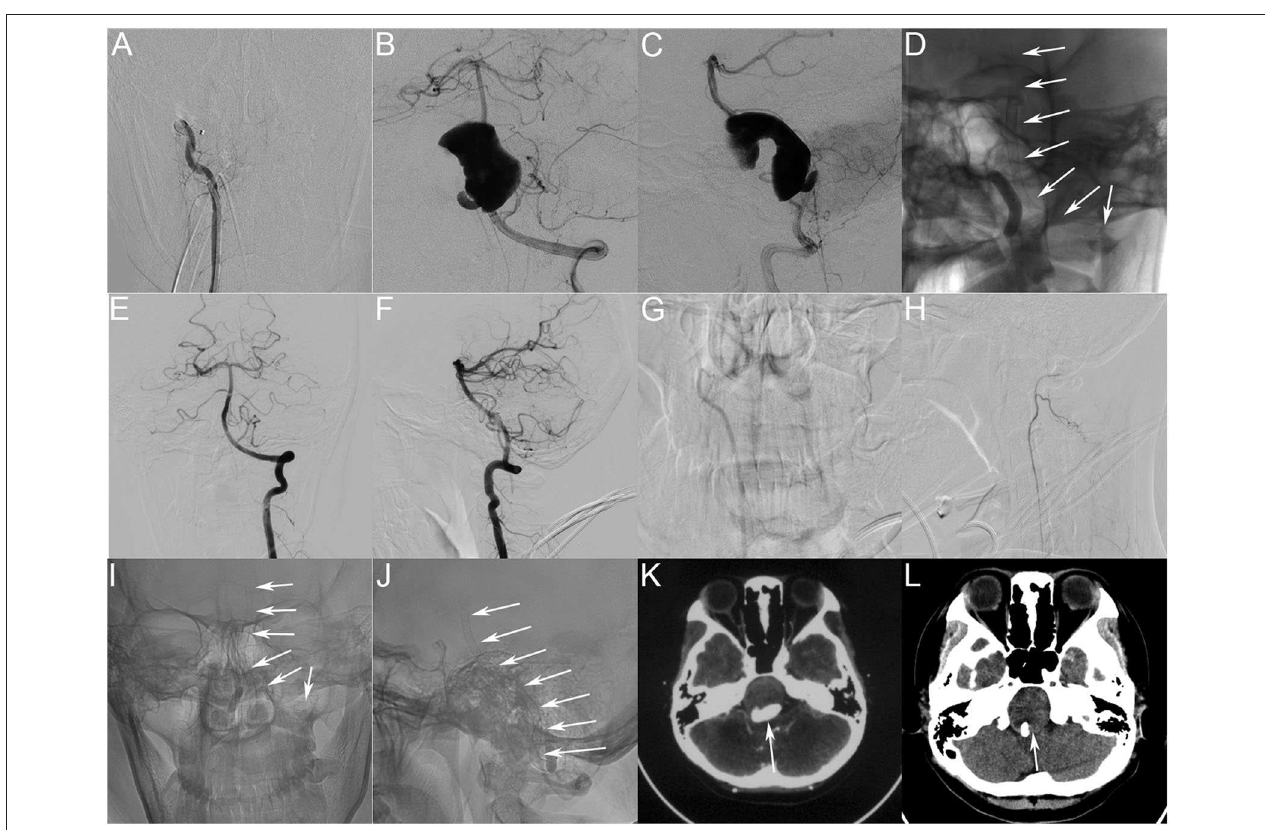
FIGURE 2 | (A) Immediately post-operative angiograms showing the complete occlusion of the RVA. (B,C) Immediately post-operative angiograms showing the reconstruction of the vertebrobasilar artery and visible contrast stasis in the lumen of the aneurysm. (D) Unsubtracted view showing good shape of the three PEDs (white arrow). (E,F) Four-month post-treatment DSA of the LVA showing complete occlusion of the aneurysm and reconstruction of the LVA and basilar artery. (G,H) Four-month post-treatment DSA of the RVA showing that the occluded RVA is thinner, and the posterior inferior cerebellar artery has good blood flow. (I,J) Four-month post-treatment angiograms (unsubtracted view) showing good shape of the PEDs (white arrow). (K,L) Four-month post-treatment computed tomographic image (L) . Compared with the preoperative image (K) the post-operative image shows decreased aneurysm size (white arrow) and increased space around the brainstem. PED, pipeline embolization device; RVA, right vertebral artery; DSA, digital subtraction angiography; LVA, left vertebral